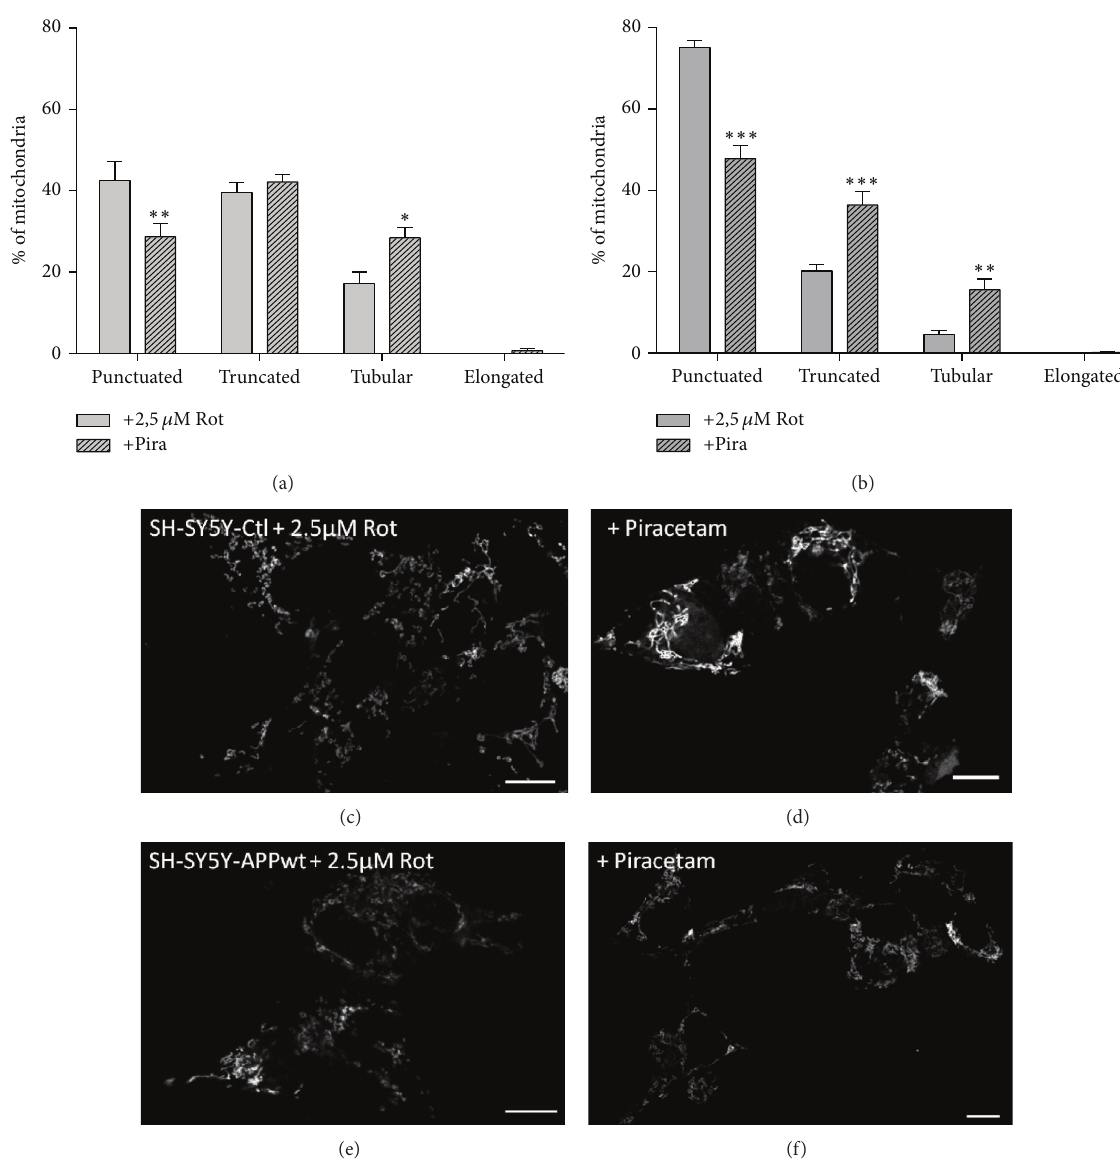
Figure 5: Piracetam ameliorates mitochondrial fission induced by complex I inhibition. Rotenone induces mitochondrial fragmentation in (a) SH-SY5Y Ctl as well as (b) SH-SY5Y APPwt cells. This impairment can be reduced by piracetam (Pira). SH-SY5Y cells were seeded and incubated for one day. Afterwards, incubation was started with 1mM piracetam (Pira) for 72 hours. During the last 24 hours, 2.5 𝜇 M